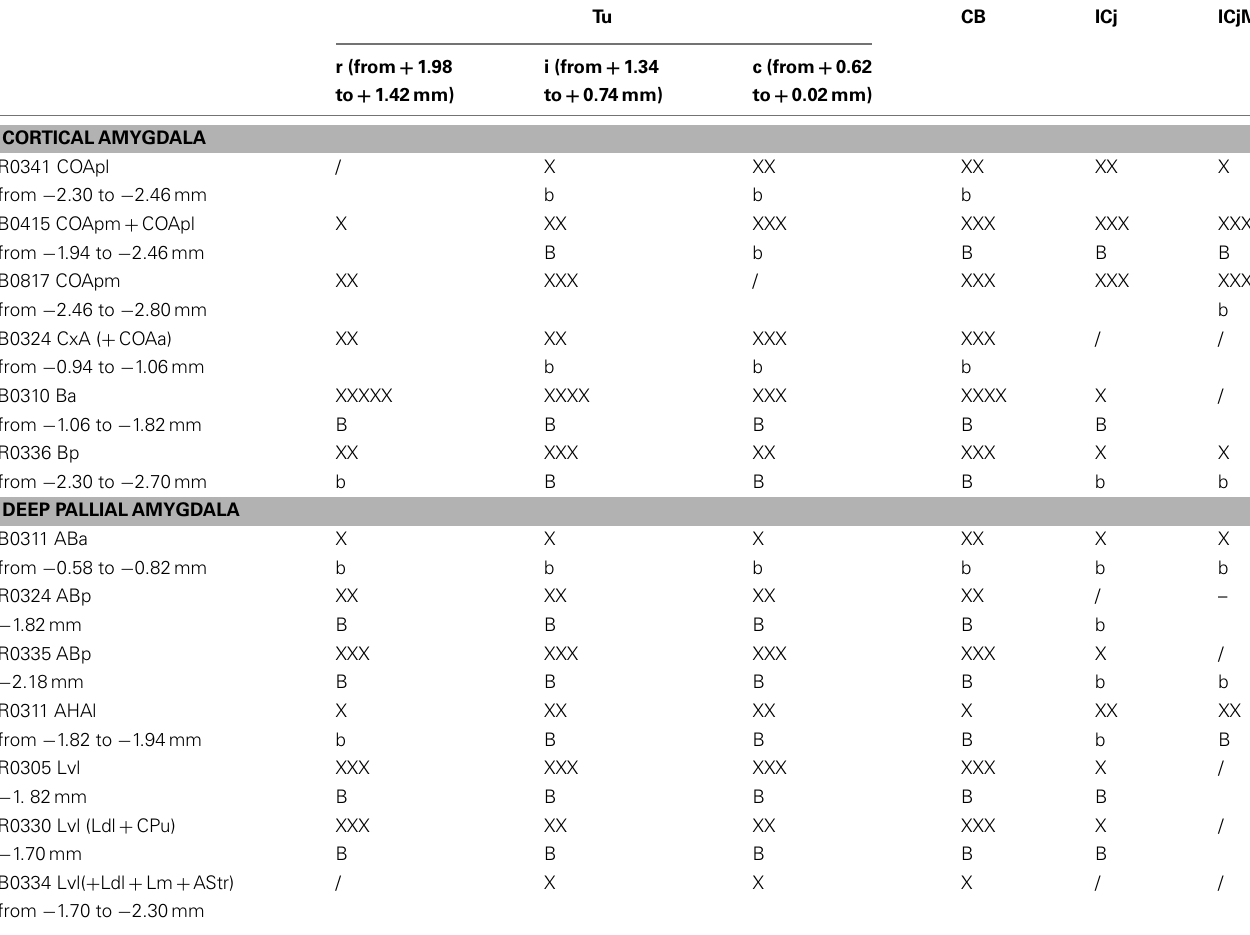
Table 3 | Semiquantitative rating of the density of the anterograde labeling found in three rostro-caudal levels of the olfactory tubercle (Tu; the antero-posterior coordinates to Bregma are indicated), the cell bridges of the ventral striatum (CB), and in association with the islands of Calleja (ICj) and the major island of Calleja (ICjM) (columns), after different injections in the cortical and deep pallial amygdala (rows).